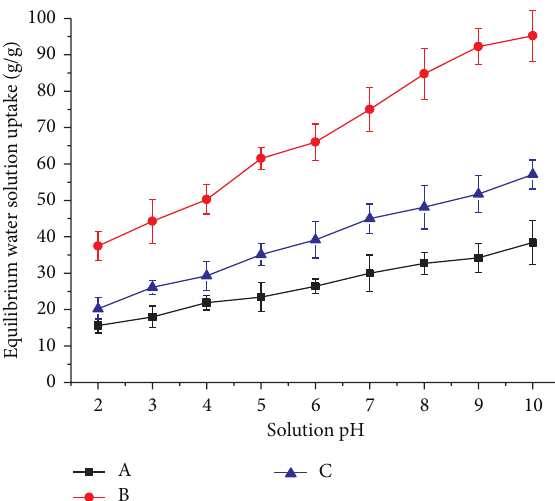
Figure 3: Hydrogel swelling kinetics in distilled water. Results are reported as mean ± standard deviation of the mean ( 𝑛 = 5 ).